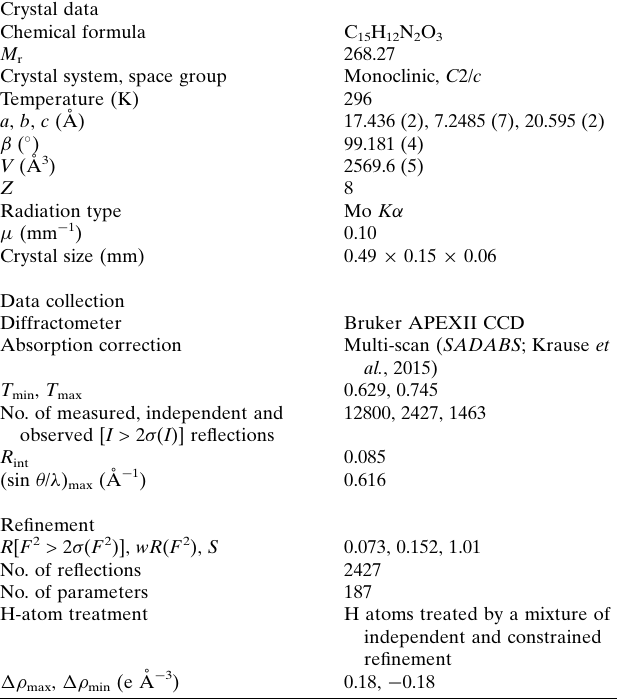
Table 3 Experimental details. Crystal data Chemical